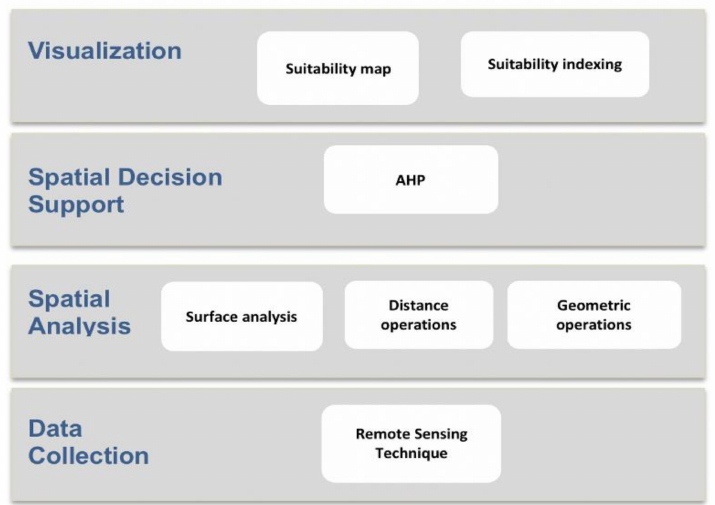
Figure 2. The proposed